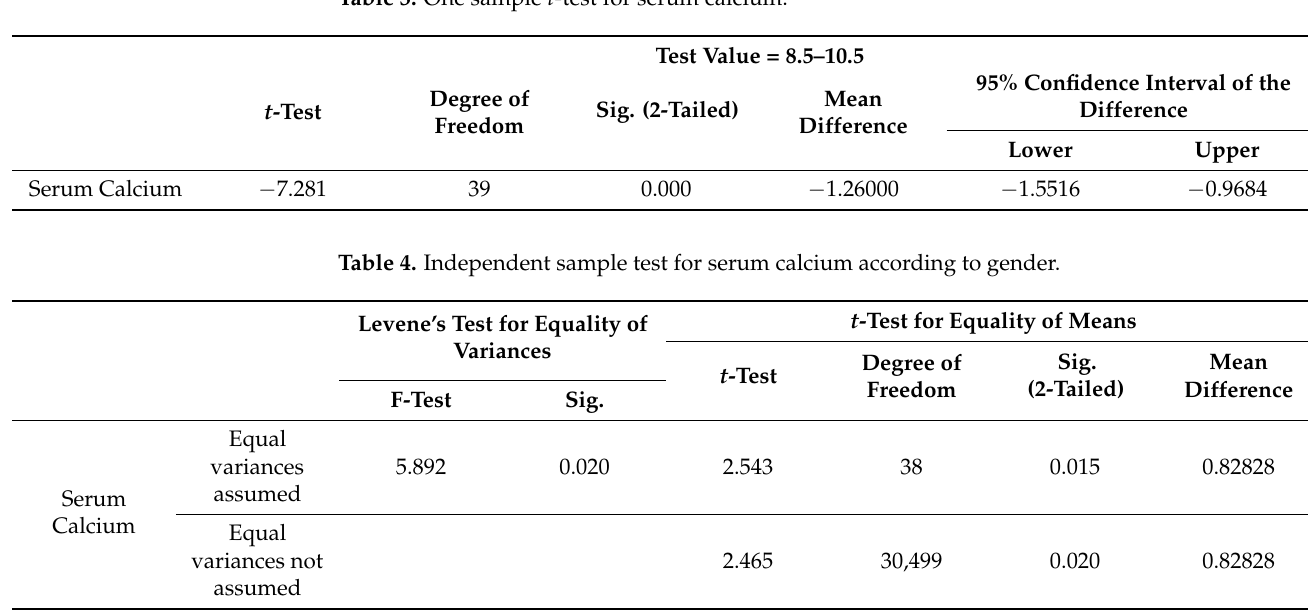
Figure 2. The hypocalcemia according to the age levels. Table 3. One sample t -test for serum calcium.